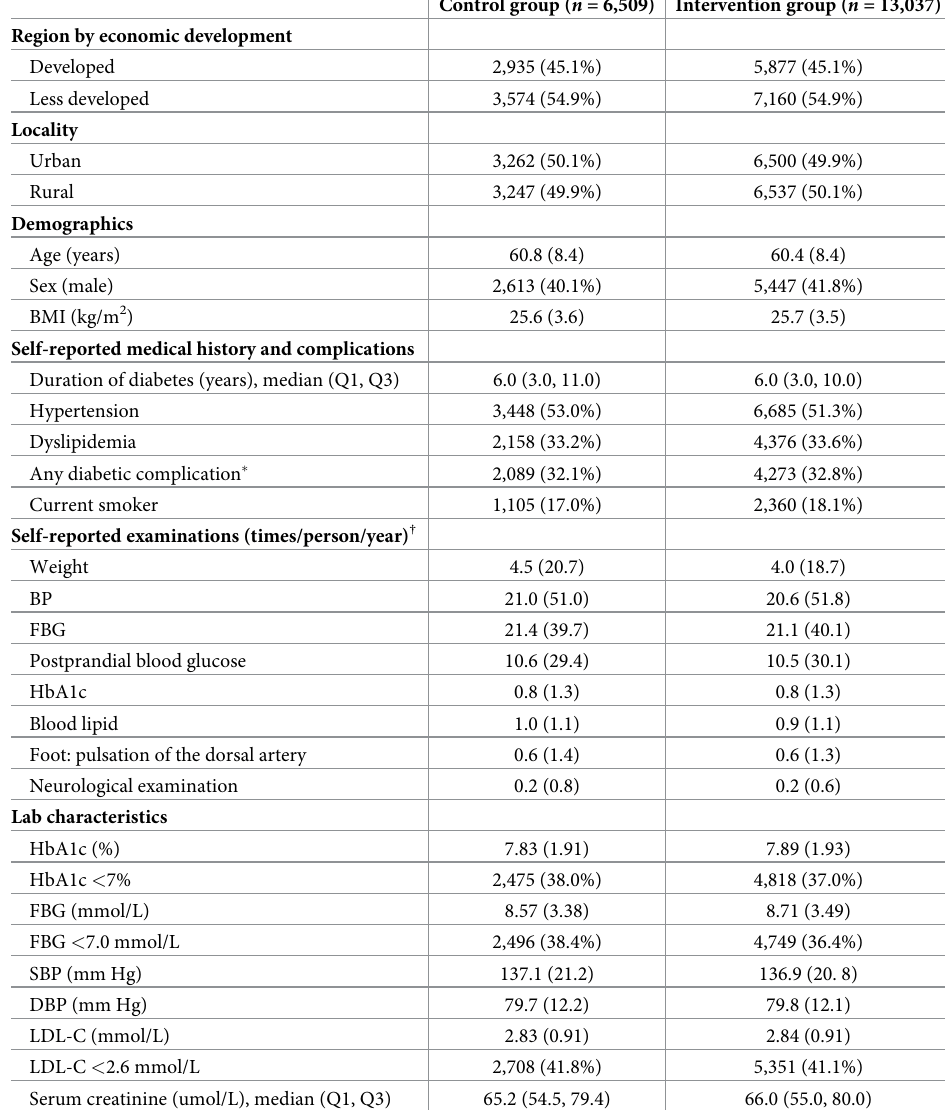
Table 1. Baseline characteristics of participants in the ROADMAP